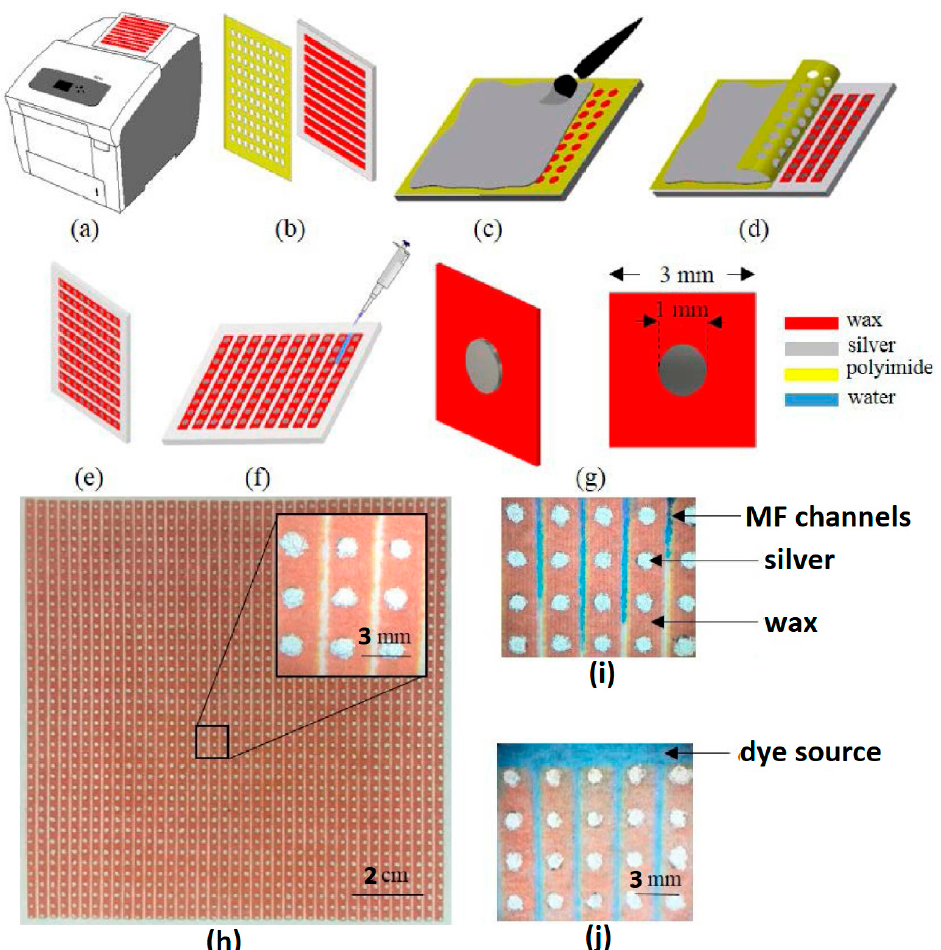
Figure 9. Fabrication process of metamaterial based microfluidic chemical sensor developed on paper substrate: ( a ) wax printer used for wax-printing on chromatography paper; ( b ) polyimide Sheet cut by CO 2 laser used as interface layer on wax printed paper; ( c ) painting silver ink; ( d ) peeling polyimide sheet off the paper; ( e ) silver-painted paper after peeling off polyimide sheet; ( f ) flow of water through the microfluidic channels; ( g ) unit cell of the proposed sensor, the thickness of the chromatography paper and conductive silver disks are 90 µm and 100 µm, respectively; ( h ) fabricated sample (dimensions of 11.5 × 11.5 cm 2 ), inhomogeneity of the silver disks due to low resolution in painting are shown on the inset figure; ( i ) flow of dye on microfluidic channel; and ( j ) channels are filled with dye, and the source of the dye is also shown (redrawn from [3]).